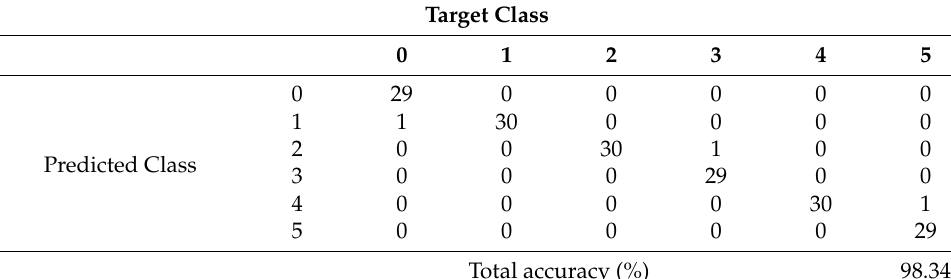
Table 7. Three common evaluation metrics results of six pipeline